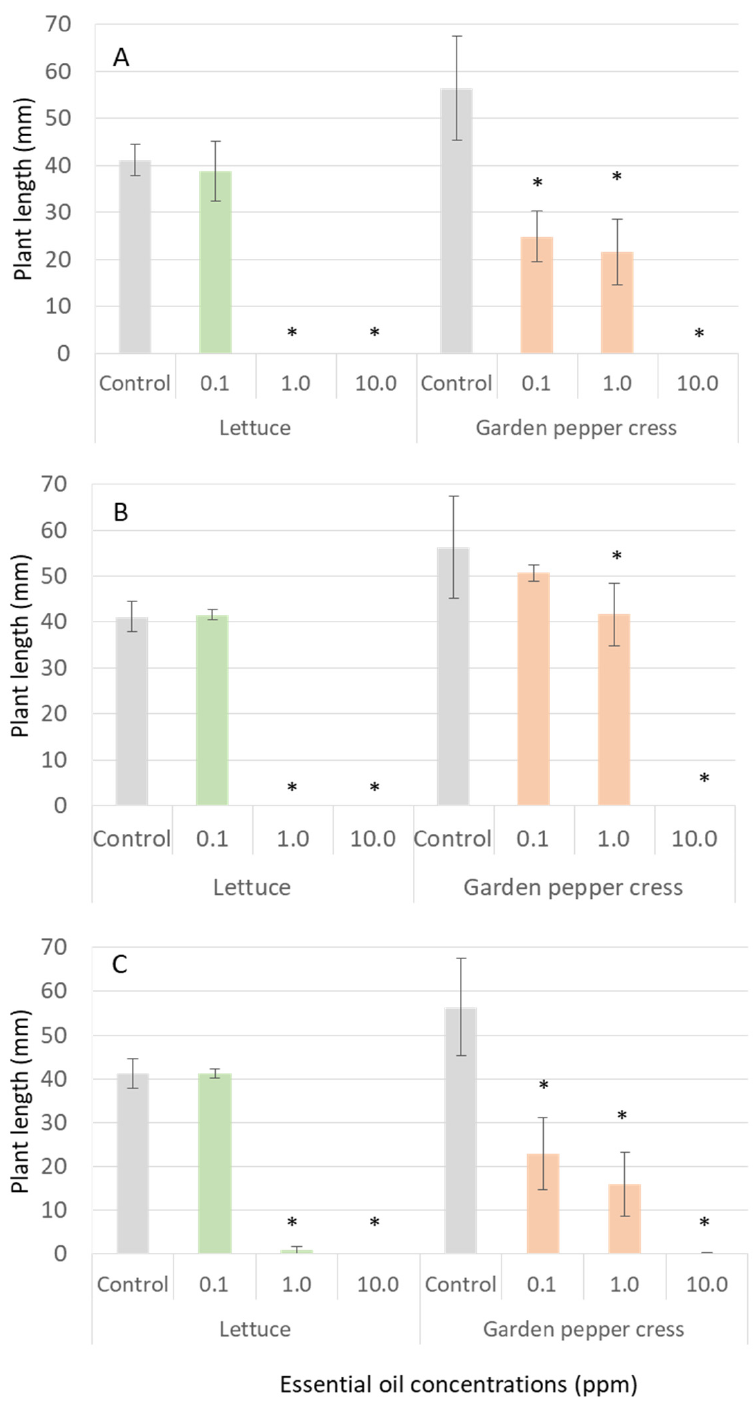
Figure 5. Inhibitory effect of S. canadensis essential oils (roots—( A ), leaves—( B ) and inflorescences—( C )) on germination and growth of lettuce and garden pepper cress (one-way ANOVA test, df = 3, p < 0.05). Data are presented as the mean of treatments (n = 60) ± SD (bars); asterisk (*) indicates a statistically significant difference compared to the control.